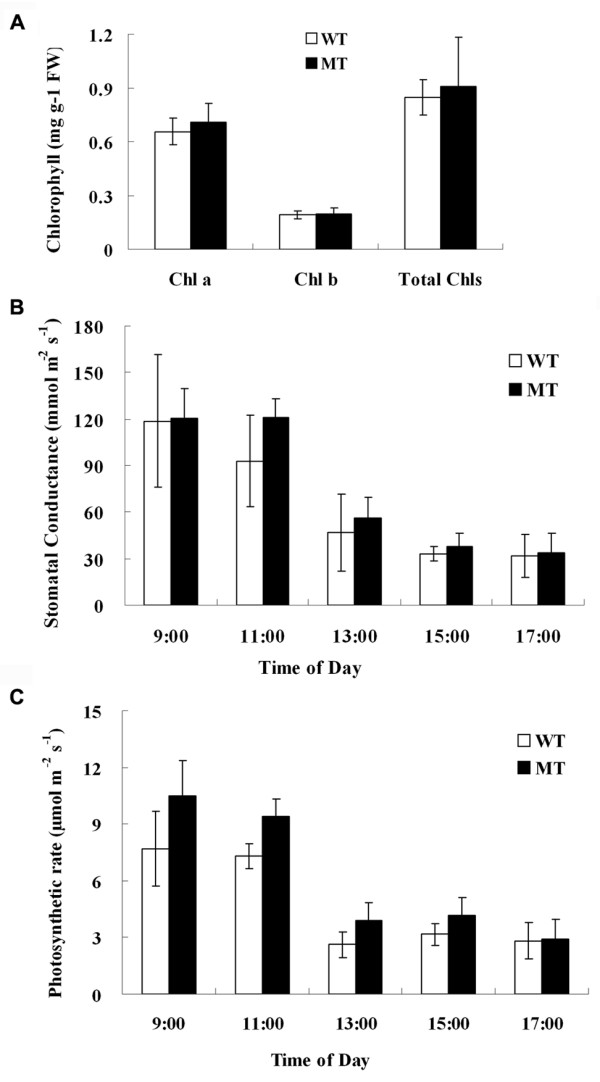
Chlorophyll content and photosynthesis activity differences in the mutant and wild type. A: chlorophyll content in leaves of mutant and wild type; B: stomatal conductance measured at five time points of the day (X-axis); C: Photosynthetic rate differences between the mutant and wild type. The stomatal conductance and photosynthetic rate were measured using a TPS-1 portable photosynthesis system. Wild type was denoted as WT (white column) and mutant as MT (black column). Three independent plants for each genotype and four leaves from each plant were measured; the average values and standard deviation were displayed.